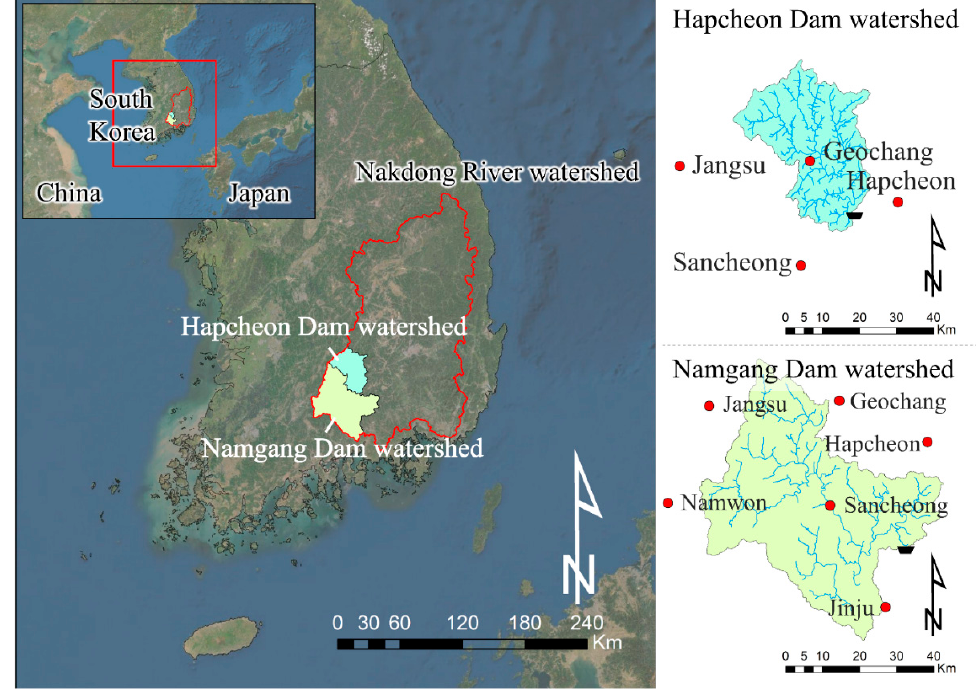
Figure 1. Study watershed and location of meteorological observation sites. The red circular symbols and black trapezoid symbol indicate the location of meteorological observation sites and dam for each watershed, respectively.